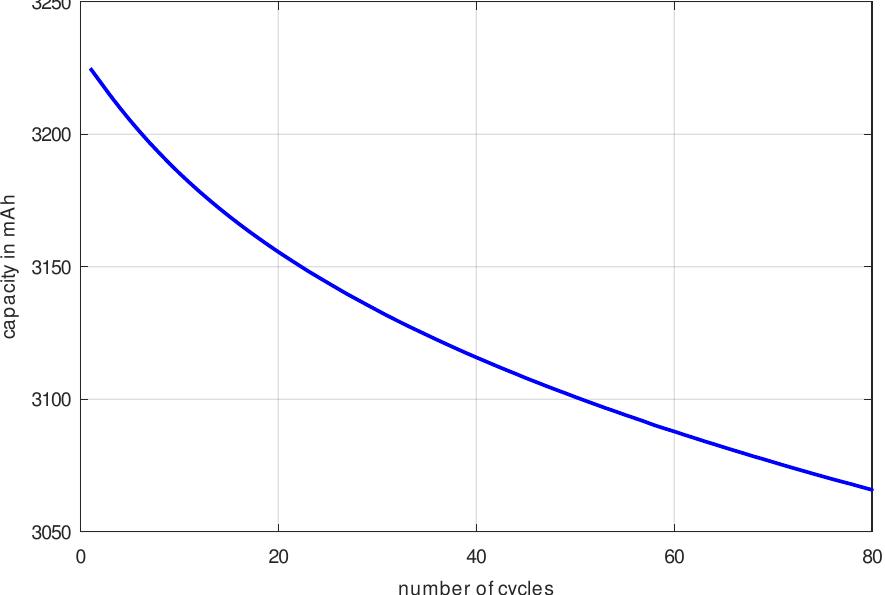
Figure 5. Reference measurement shows capacity decrease observed over the measurement